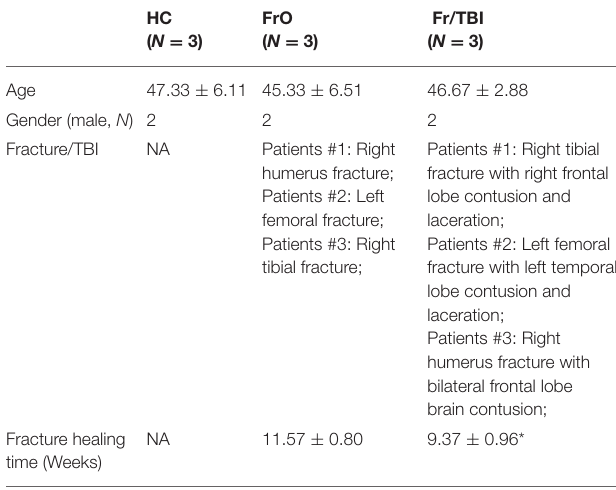
TABLE 1 | Demographic